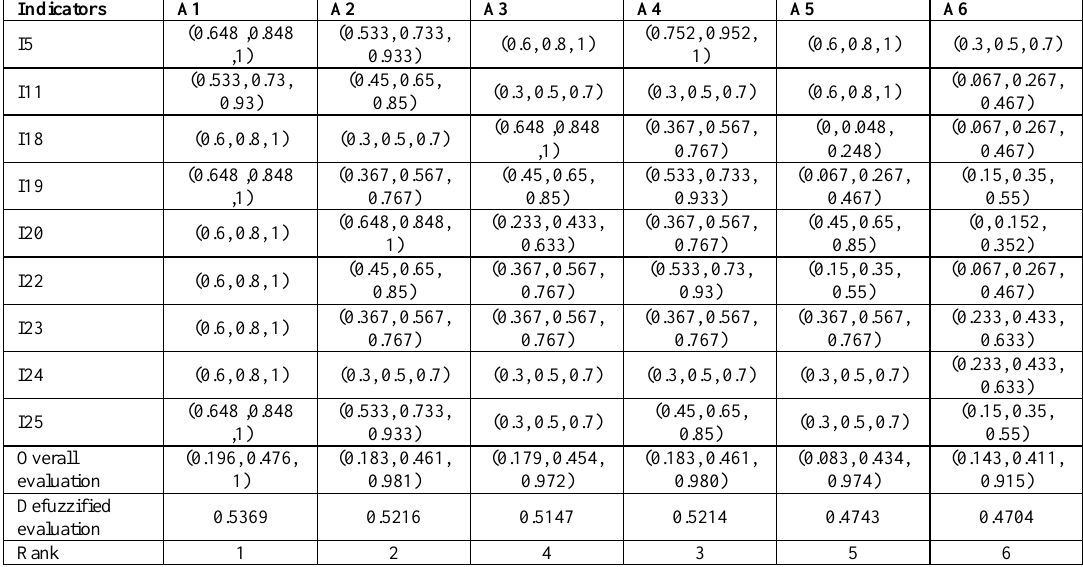
Table 5. Consensual subjective evaluations, overall fuzzy, defuzzified evaluations, and final